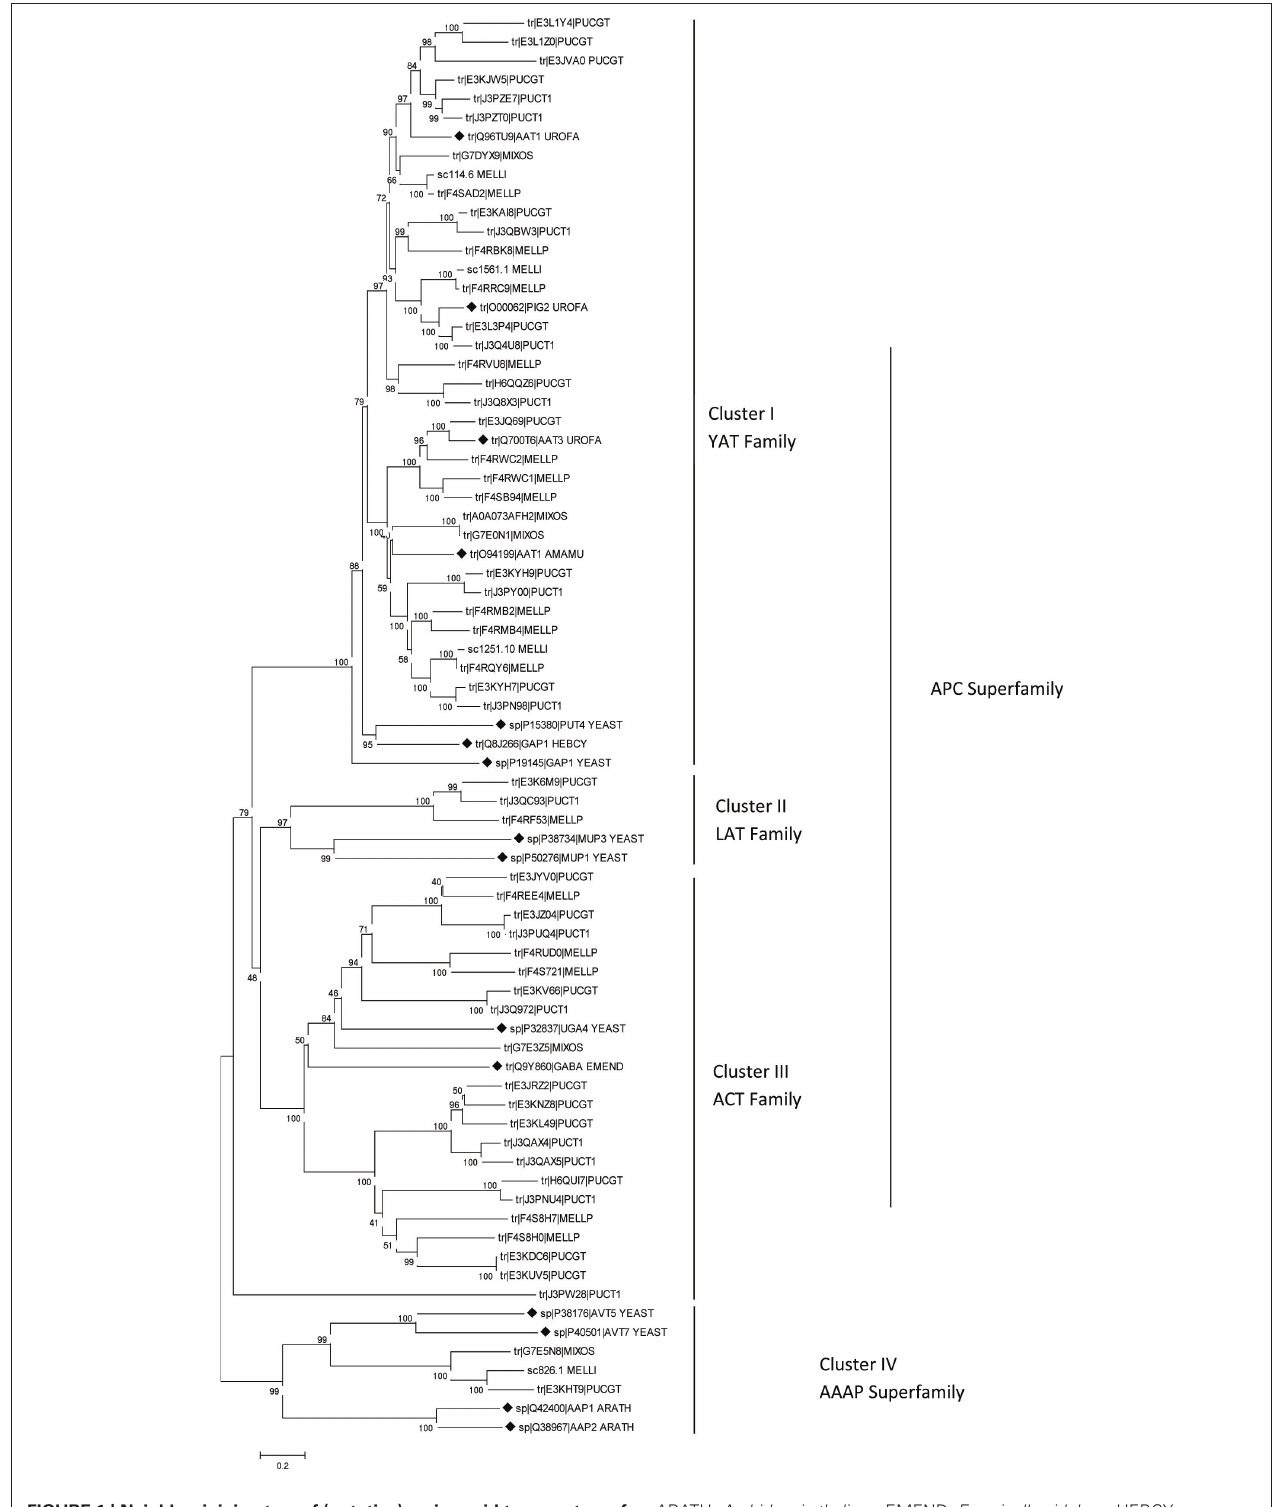
FIGURE 1 | Neighbor joining tree of (putative) amino acid transporters of rust fungi based on full-length amino acid sequences. Bootstrap values indicated next to branches are from 1000 replications. The formerly characterized transporters are labelled by black diamonds. Sequences are designated with Uniprot ID and five letter species